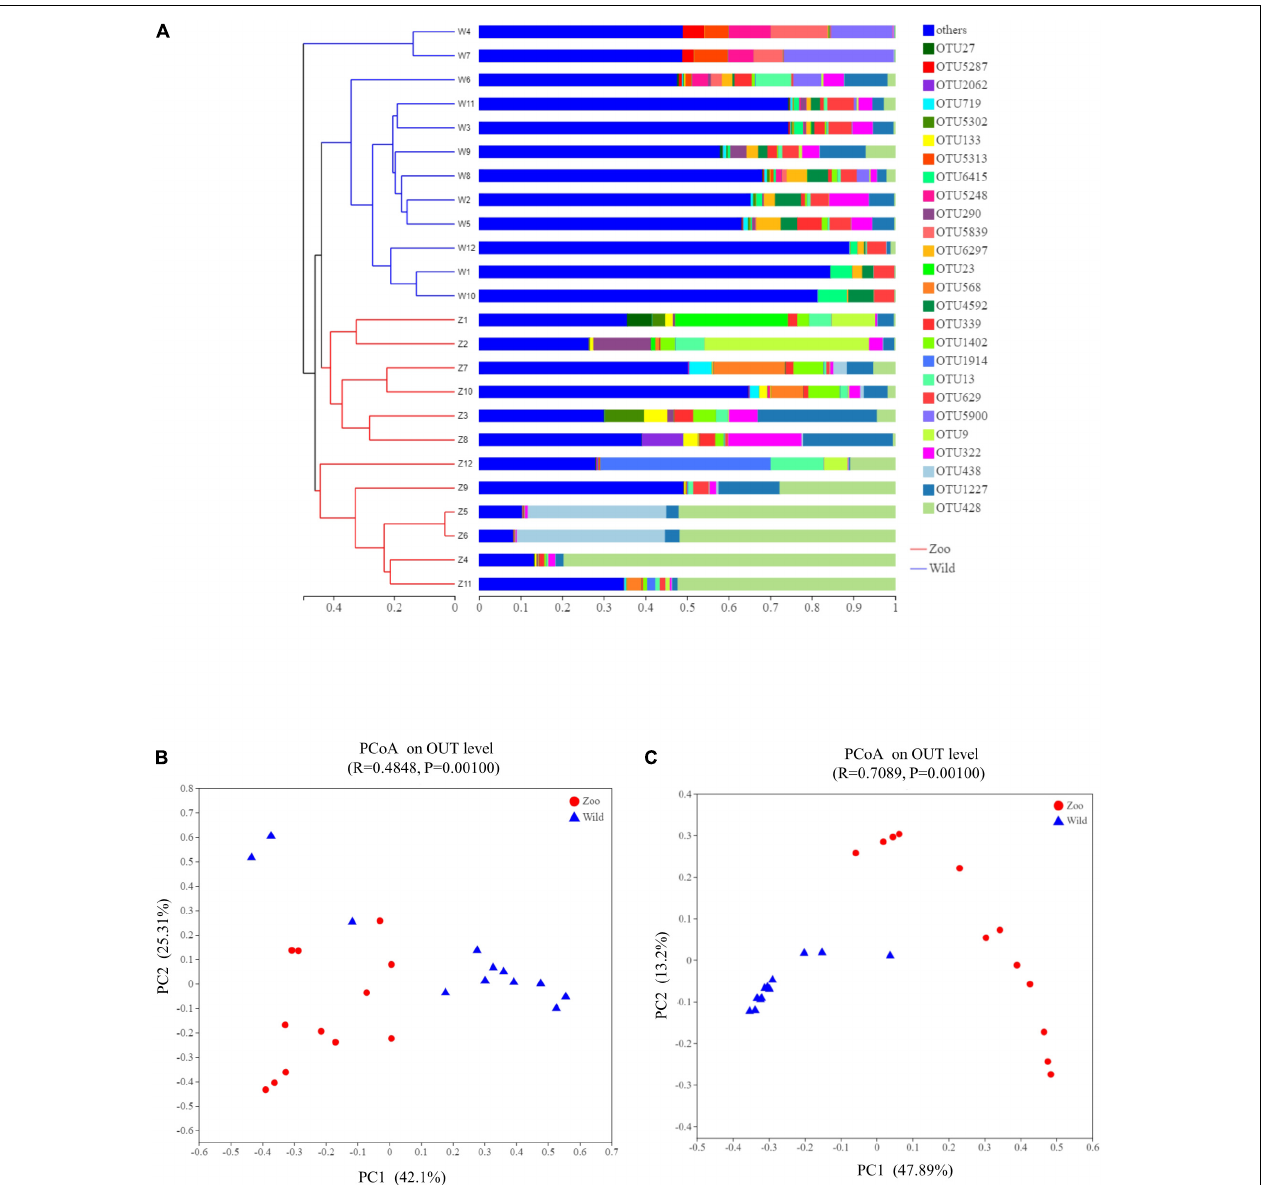
FIGURE 3 | Clustering analysis of the gut microbiotas and PCoA plots analysis. (A) Clustering analysis of the evolution of gut microbiotas in the Z and W groups. Gut microbiota trees were generated based on the Bray–Curtis distances generated by mothur. (B) PCoA plots based on weighted UniFrac distances of gut microbiome of oriental white storks. (C) PCoA plots based on unweighted UniFrac distances of gut microbiome of oriental white